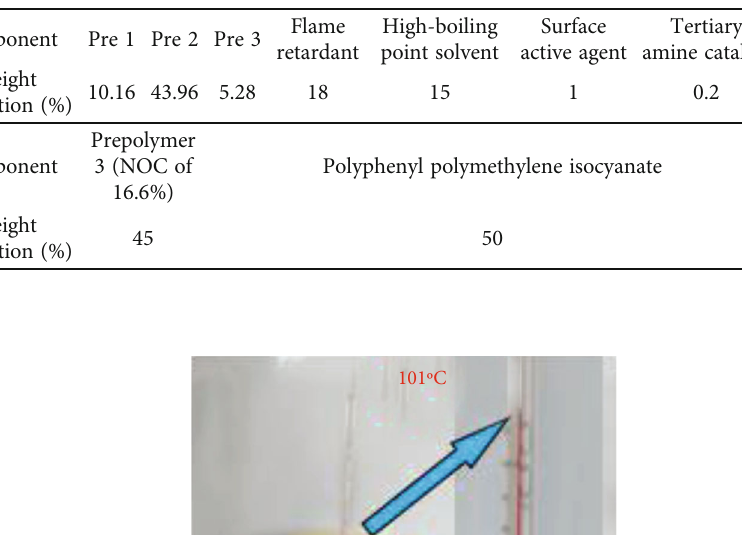
Table 6: Proportions of low exothermic polymer grouting material (%).